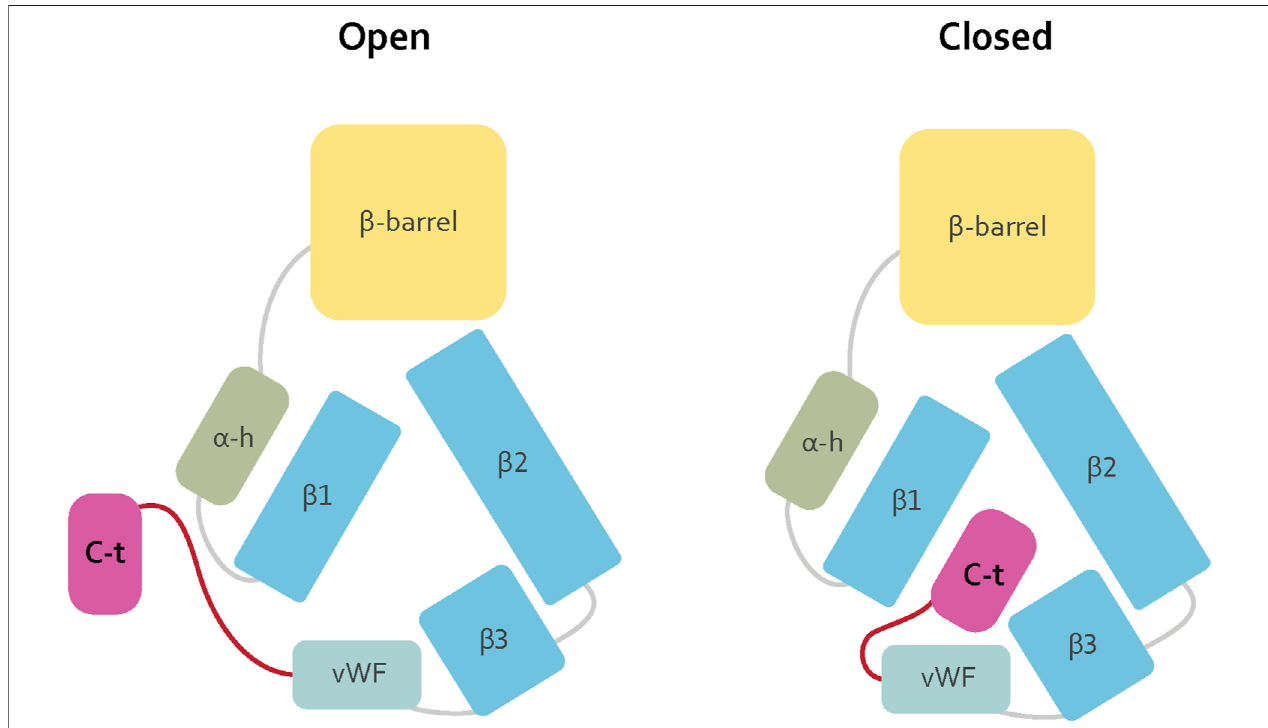
FIGURE 3 | We suggest that the fl exibility loop (red) connecting the C-terminal region (magenta) to the vWF domain (cyan), in addition to the electrostatic forces (shownin Figure2D ),contributestoaconformationalchangeinVg.Inan “ open ” conformation,theC-terminalregionis fl ankingonthesideofthelipidbindingsite(blue) and α -helical subdomain (green). However, when a shielding of the lipid binding site is necessary, for example, during storage or transport of lipid molecules, the loop region is fl exible so that the C-terminal region can be positioned over the lipid binding site. The position is likely to contribute to a more soluble